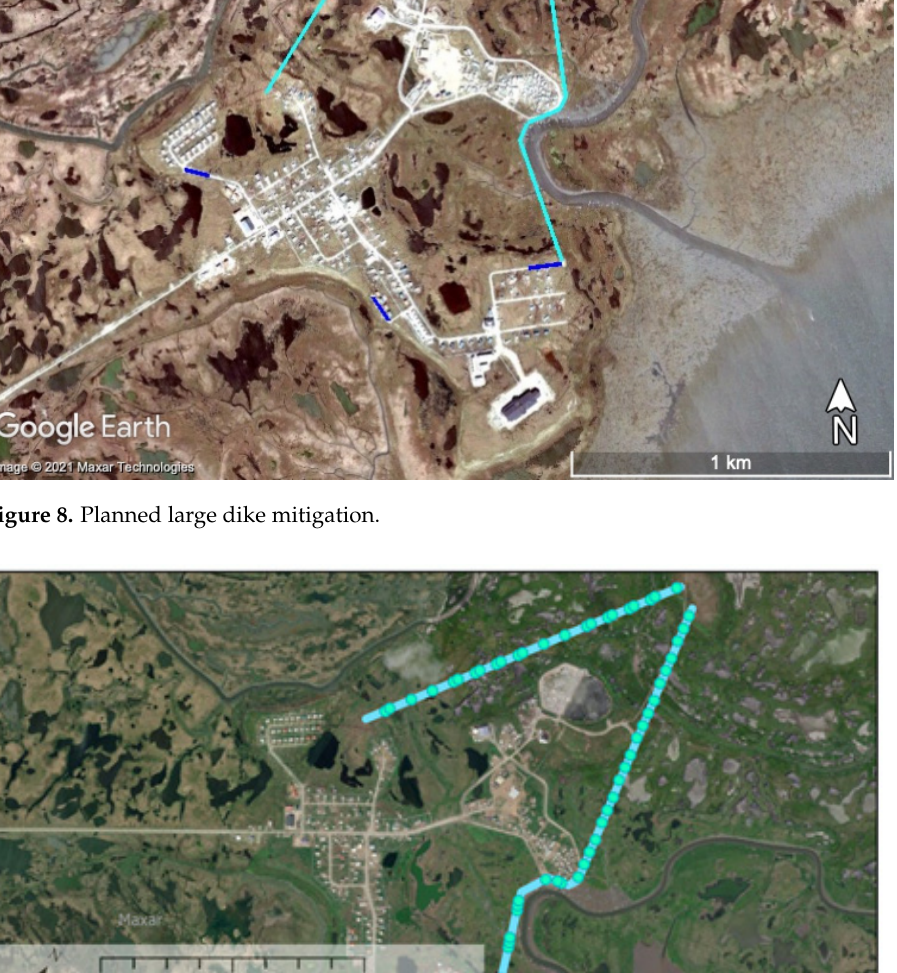
Figure 9. Model points used to estimate the large dike height.